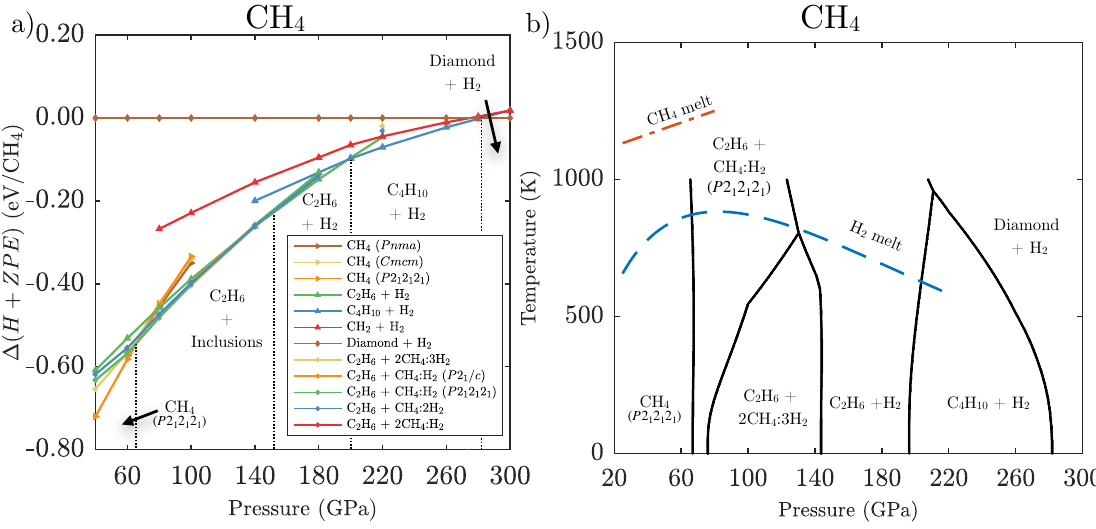
Figure 7. ( a ) Zero temperature free energies including ZPE calculated for relevant CH 4 phases and phase mixtures relative to decomposition into diamond and H 2 . ( b ) Pressure-temperature phase diagram for CH 4 calculated using the harmonic approximation. Black lines indicate predicted phase transitions between phases, the blue dashed line indicates the H 2 melt line as calculated by Bonev et al. [61], the red dashed line indicates the CH 4 melting line as determined by Hirai et al.